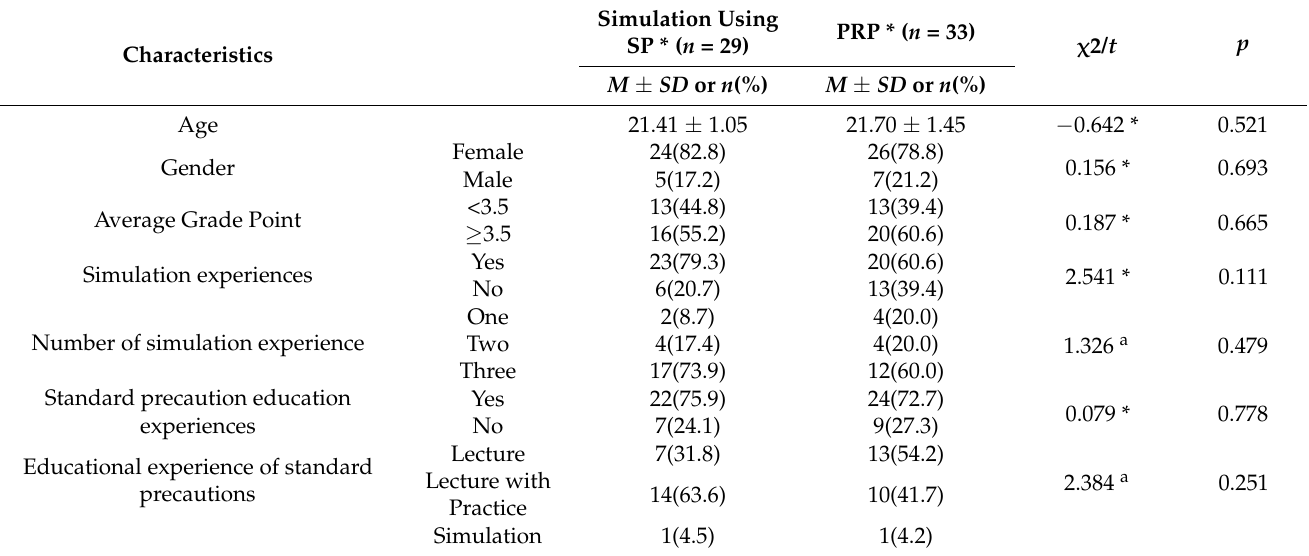
Table 2. General Characteristics of Participants of the two